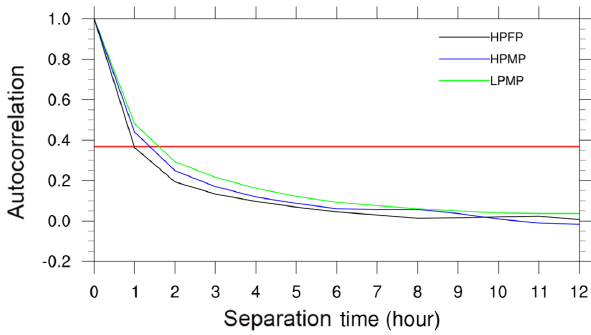
Figure 12. Same as in Fig. 2 but for the averaged temporal autocor- relation.